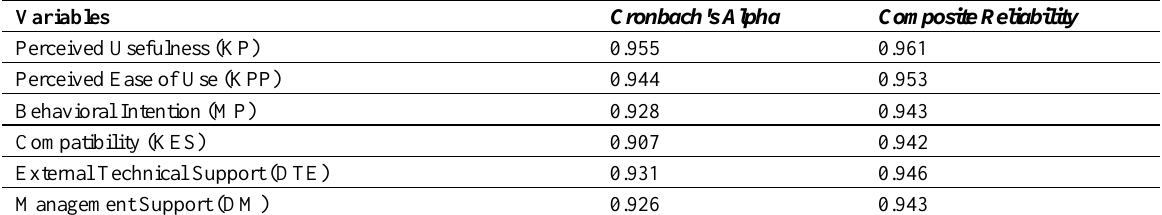
Table 3: Reliability Test Results